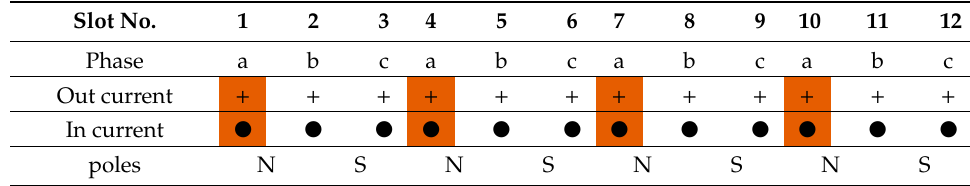
Table 4. 12 slot winding currents for 120 ◦ phase belt toroidal winding solid rotor induction motor. Slot No.